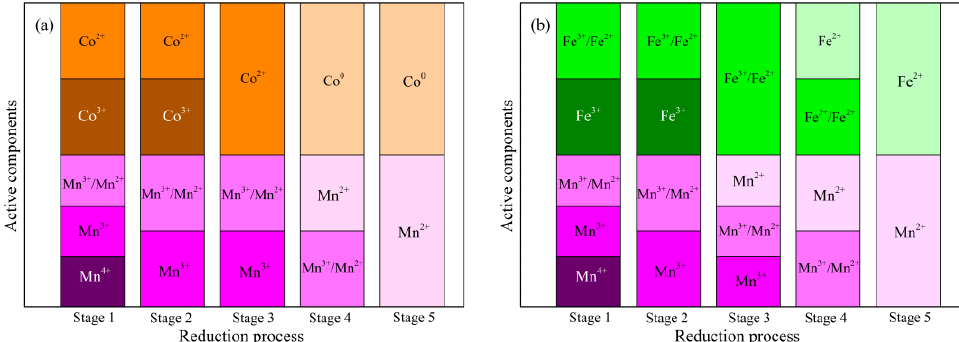
Figure 4. The qualitative component states of active elements during reduction process. Table 2. H 2 -TPR quantitative analysis of Mn−Co/TiO 2 and Mn−Fe/TiO 2 nanocatalysts.